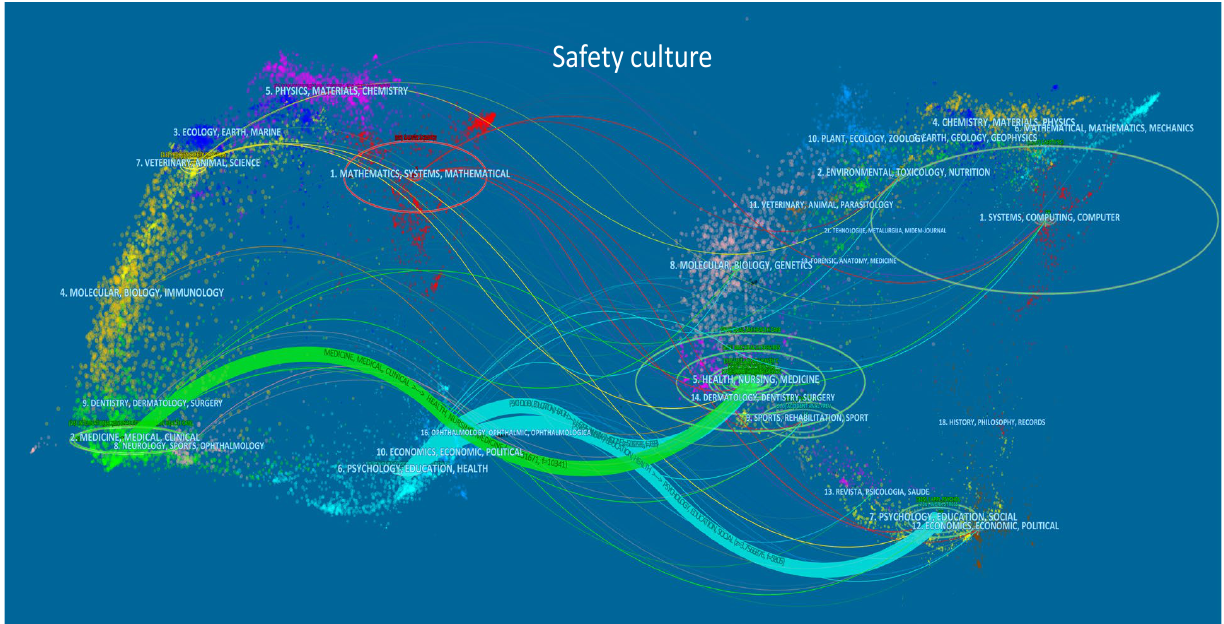
Figure 5. Dual-overlay map of safety culture publications (generated using CiteSpace, see Section 2.2 for references). Note: the left-side clusters represent citing domains while the right-side clusters are cited domains; 273 citing journals and 6842 cited journals were mapped